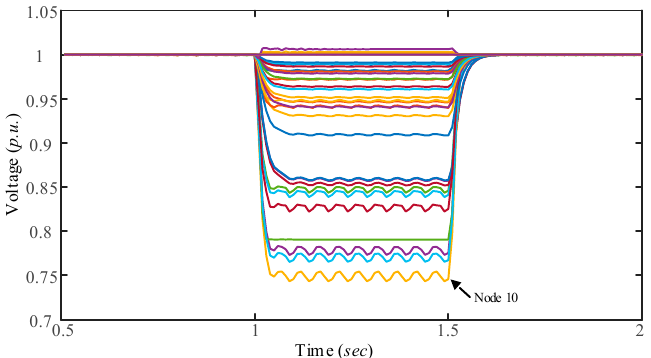
Figure A4. Voltage drop curve of nodes when node 10 fails.